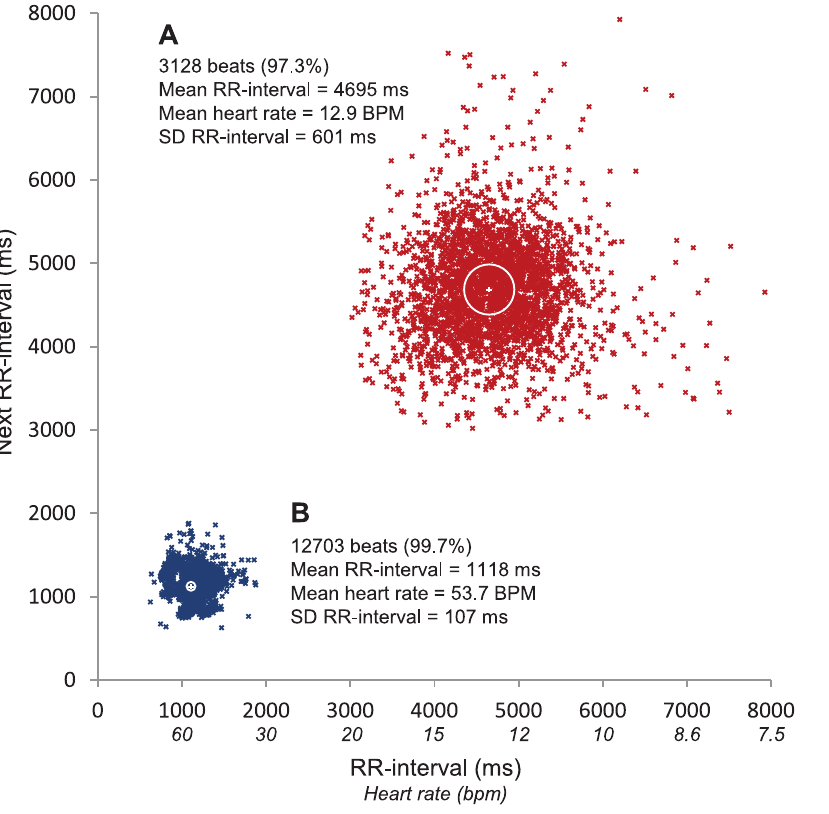
Figure 4. Examples of 4 hour heart rate recordings from two different fish from the control groups. (A) The fifth recording day after anaesthesia in a fish that received an injection of buprenorphine. (B) The first recording day after anaesthesia in a fish that did not receive an injection of buprenorphine. The white cross in the centre of each cloud indicates the mean heart rate for the 4 hour recording period and the white circle indicates the heart rate variability (HRV).